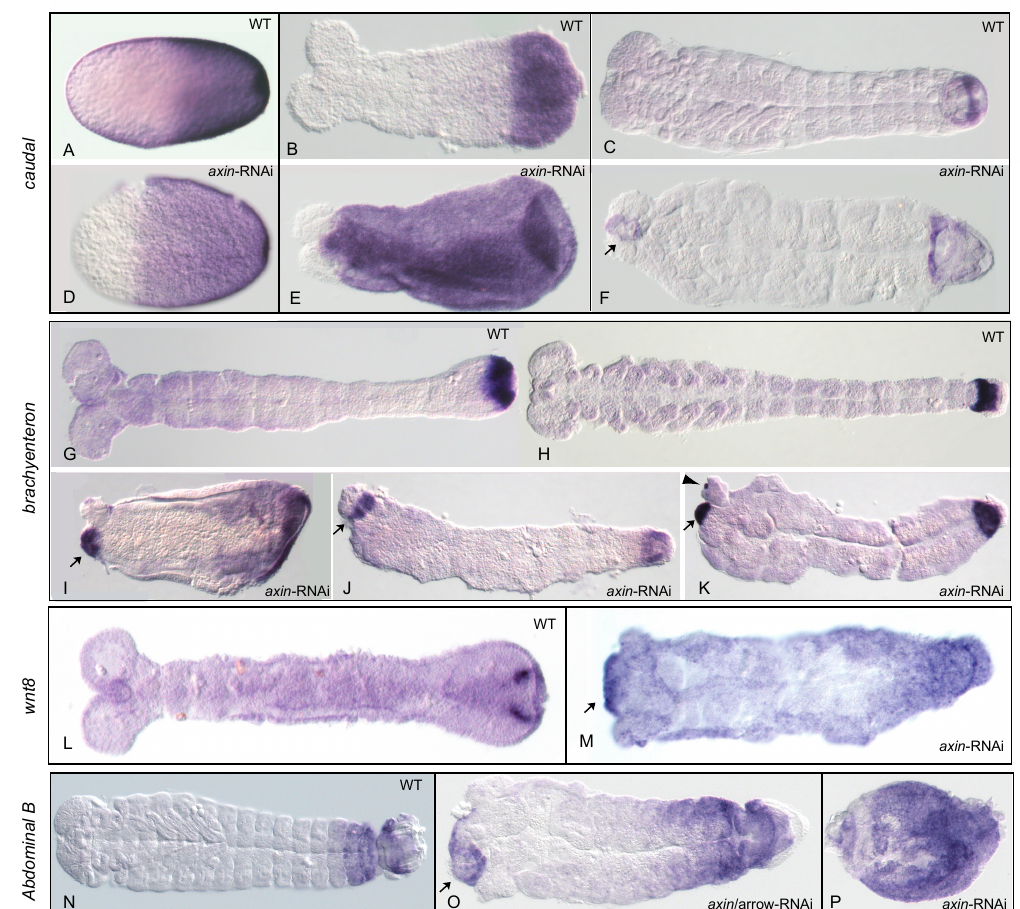
Figure 3. Analysis of posterior marker gene expression in Tc-axin RNAi embryos. ( A – C ) Tc-caudal expression in successively older wild-type embryos ( D ) Tc-axin RNAi blastoderm embryo: anterior expansion of Tc-caudal expression covering the embryonic region. ( E ) Tc-caudal is highly overexpressed in a Tc-axin RNAi embryo leaving free only the most anterior tissue. ( F ) Tc-axin RNAi embryo after completion of segmentation: ectopic Tc-cad expression at the anterior (arrow). ( G , H ) In the wild-type, Tc-brachyenteron ( Tc-byn ) is exclusively expressed in the precursor of the hindgut at the posterior. ( I – K ) Tc-axin RNAi embryos showing ectopic Tc-byn expression at the anterior (arrow). ( I ) Tc-byn expression is strongly expanded at the posterior of a young germ anlage. ( K ) Two ectopic Tc-byn domains are visible at the anterior (arrow, arrow-head); ( L ) Tc-wnt8 is detectable in two spots in the growth zone in the wild-type but diffuse throughout a Tc-axin RNAi-embryo ( M ) and upregulated at the anterior (arrow). ( N ) Tc-Abdominal B is expressed in the posterior segments and the hindgut anlagen in the wild-type. ( O ) Tc - axin-arrow -double RNAi: AbdB expression is seen expanded in the posterior abdomen and ectopic at the anterior (arrow). ( P ) Tc-axin -RNAi upregulated throughout the embryo.